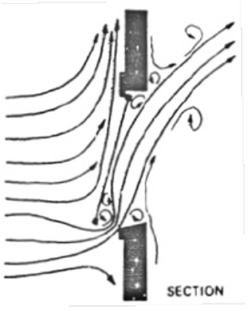
Figure 1. Airflow on the tipping window.